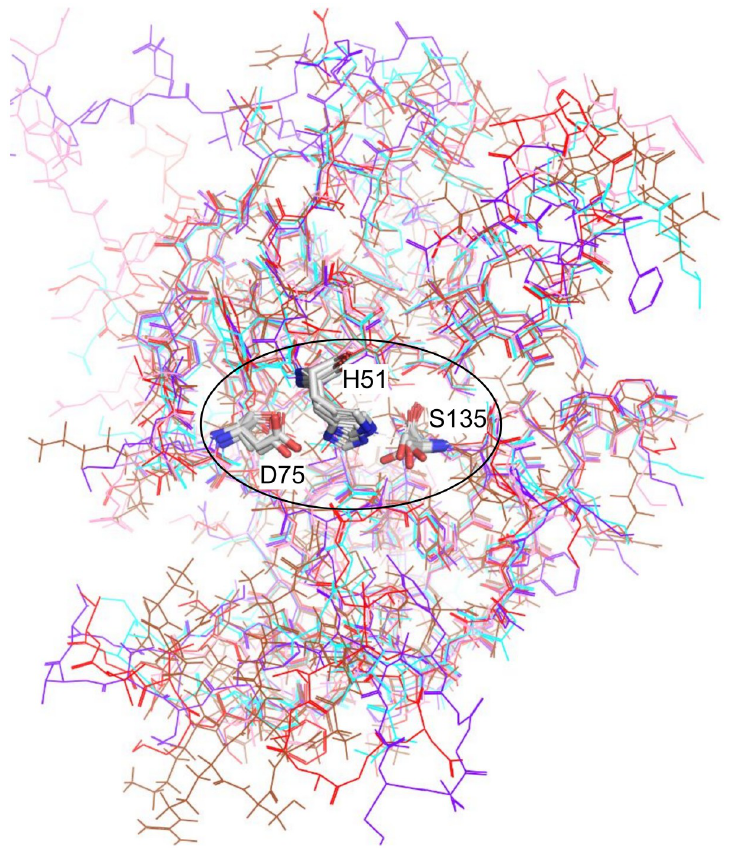
Fig 2. Superimposed view of the protease structures from all five serotypes. The three conserved active site residues, H51, D75 and S135 at the center are shown in stick model and encircled with a black outline. Color key for line models: cyan, type 1 (PDB: 3L6P); brown, type 2 (PDB: 4M9T); violet, type 3 (PDB: 3U1J); red, type 4 (PDB: 2VBC); pink, type 4T (PDB: 2WHX).